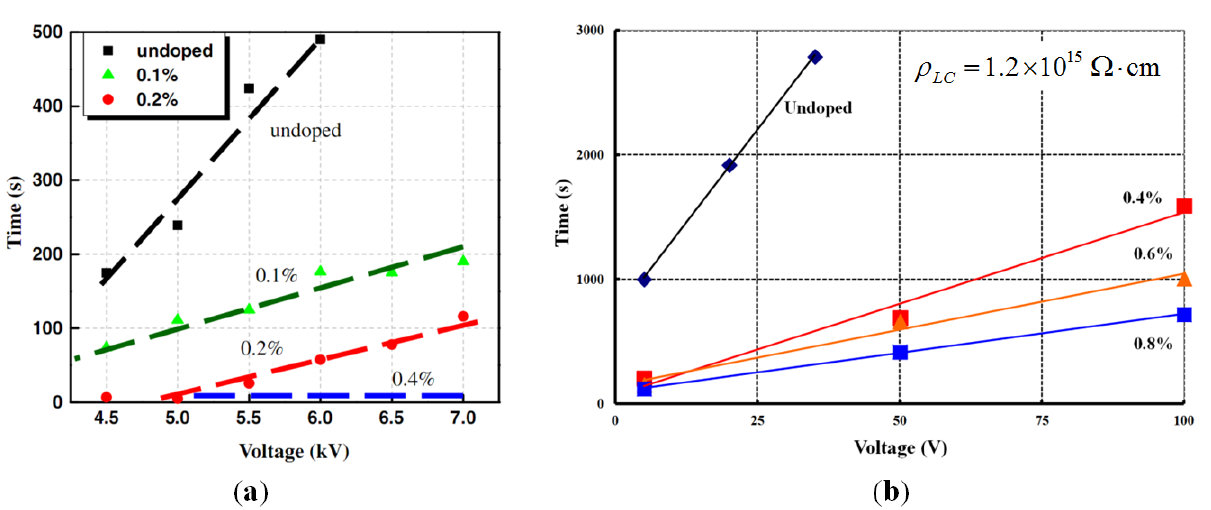
Figure 15. Relation between the residual time and the applied voltage for the samples of ( a ) 1 × 10 13 Ω∙cm and ( b ) 1.2 × 10 15 Ω∙cm with various ITO concentrations, where the x -axis is the applied voltage and the y -axis is the residual